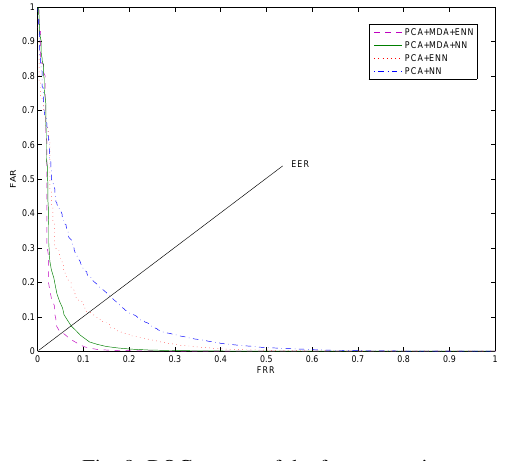
Fig. 8. ROC curves of the four strategies.